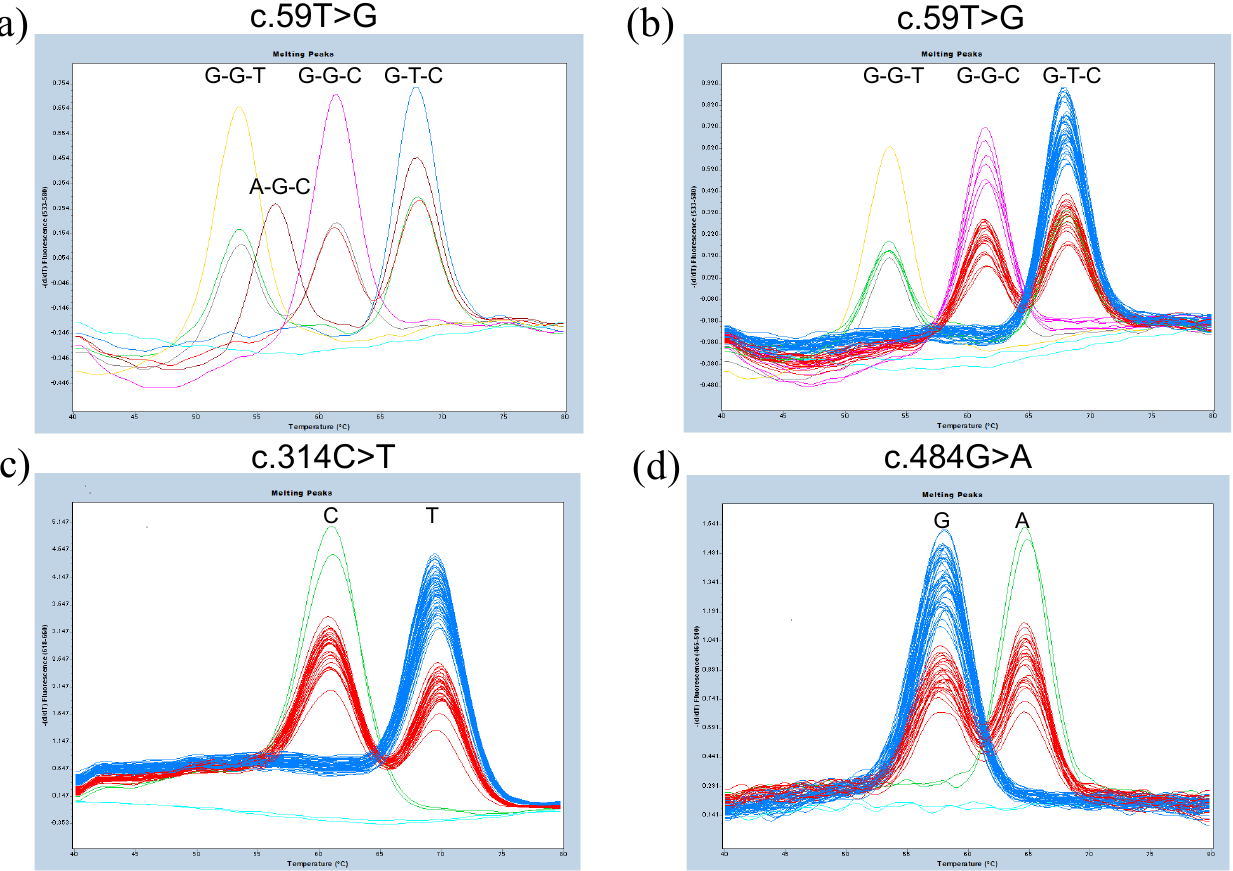
Figure 2. Melting peak profiles of probe-based FMCA for detection of SNPs of FUT3 . ( a ) Melting peak profiles of probe-based FMCA for detection of 59T>G of seven selected subjects whose genotypes were already determined to be 55G>A, 59T>G, and 61C>T. Subjects with genotypes of G-T-C/G-T-C at 55-59-61 are shown in blue, G-T-C/G-G-C in red, G-G-C/G-G-C in pink, G-T-C/G-G-T in green, G-G-C/G-G-T in gray, G-G-T/G-G-T in yellow, and G-T-C/A-G-C in brown. Negative control is shown in light blue. ( b ) Melting peak profiles of probe-based FMCA for detection of 59T>G of 76 Ghanaian subjects. ( c ) Melting peak profiles of probe-based FMCA for detection of c.314C>T of 90 Caucasians whose genotypes were known. The subjects with genotypes of C/C at c.314C>T are shown in blue, C/T in red, T/T in green. Negative control is shown in light blue. ( d ) Melting peak profiles of probe-based FMCA for detection of c.484G>A of 76 Ghanaians whose genotypes were previously determined. The subjects with genotypes of G/G at c.484G>A are shown in blue, G/A in red, A/A in green. Negative control is shown in light